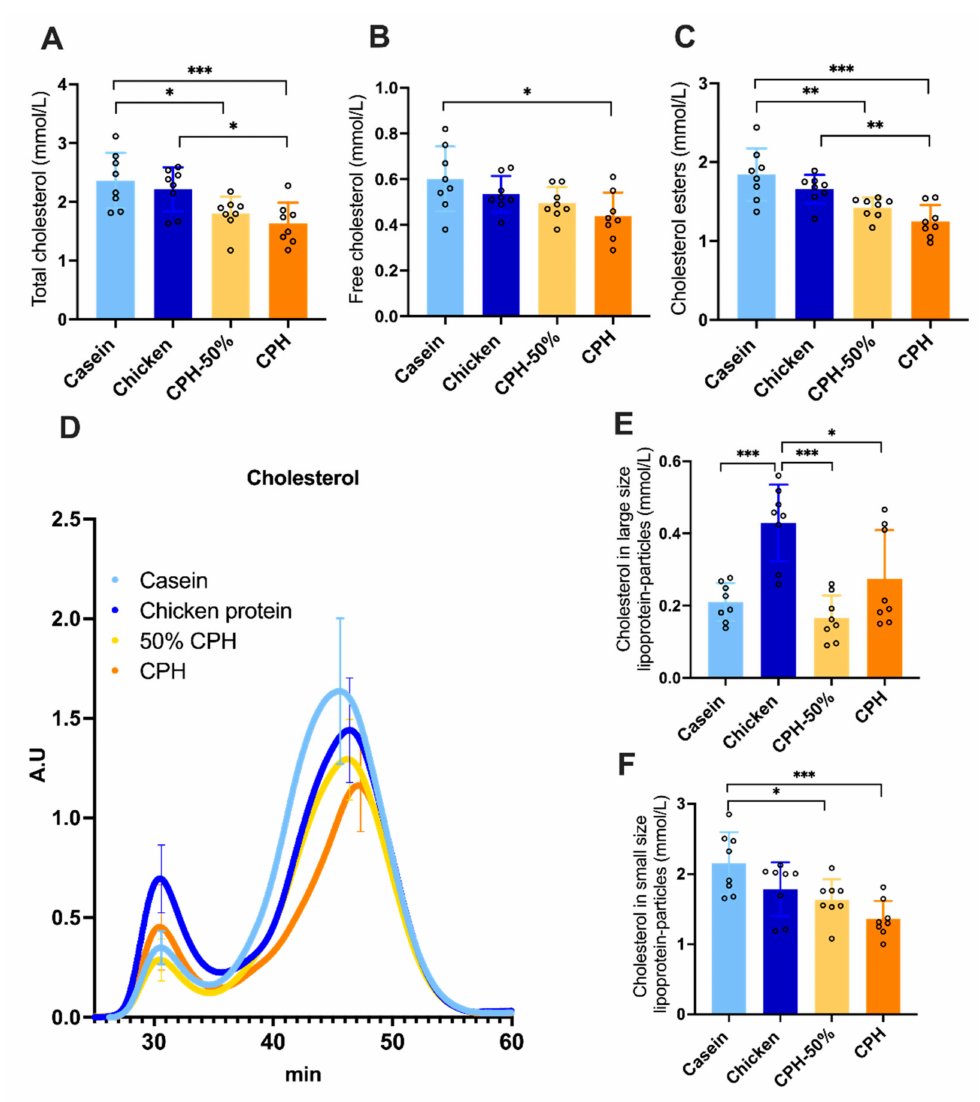
Figure 2. Dose effect on plasma cholesterol levels in Wistar rats fed high-fat diets with casein, chicken meat, or different amounts of chicken protein hydrolysate for 12 weeks. In the 50% CPH group, 50% of the protein source was casein. ( A ) Enzymatic measurement of total cholesterol and ( B ) free cholesterol, ( C ) calculated values of cholesterol esters from ( A , B ). ( D ) Chromatogram from size-exclusion chromatography analysis of cholesterol in lipoprotein particles. ( E ) Cholesterol concentration in large size and ( F ) smaller sized lipoprotein particles. Means values with standard deviation are given, and circles indicate individual values ( n = 8). Significant difference in ( A – F ) was determined by one-way ANOVA with Tukey’s multiple comparisons test between all diet groups (* p < 0.05, ** p < 0.01, *** p <